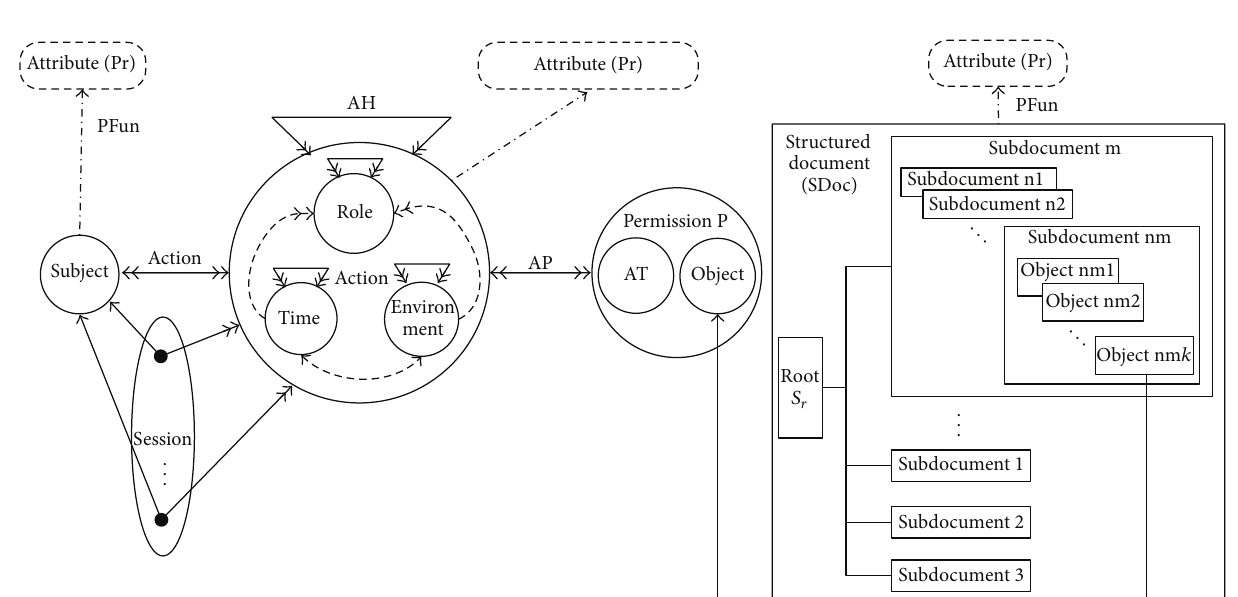
Figure 1: The nesting relationship between objects.